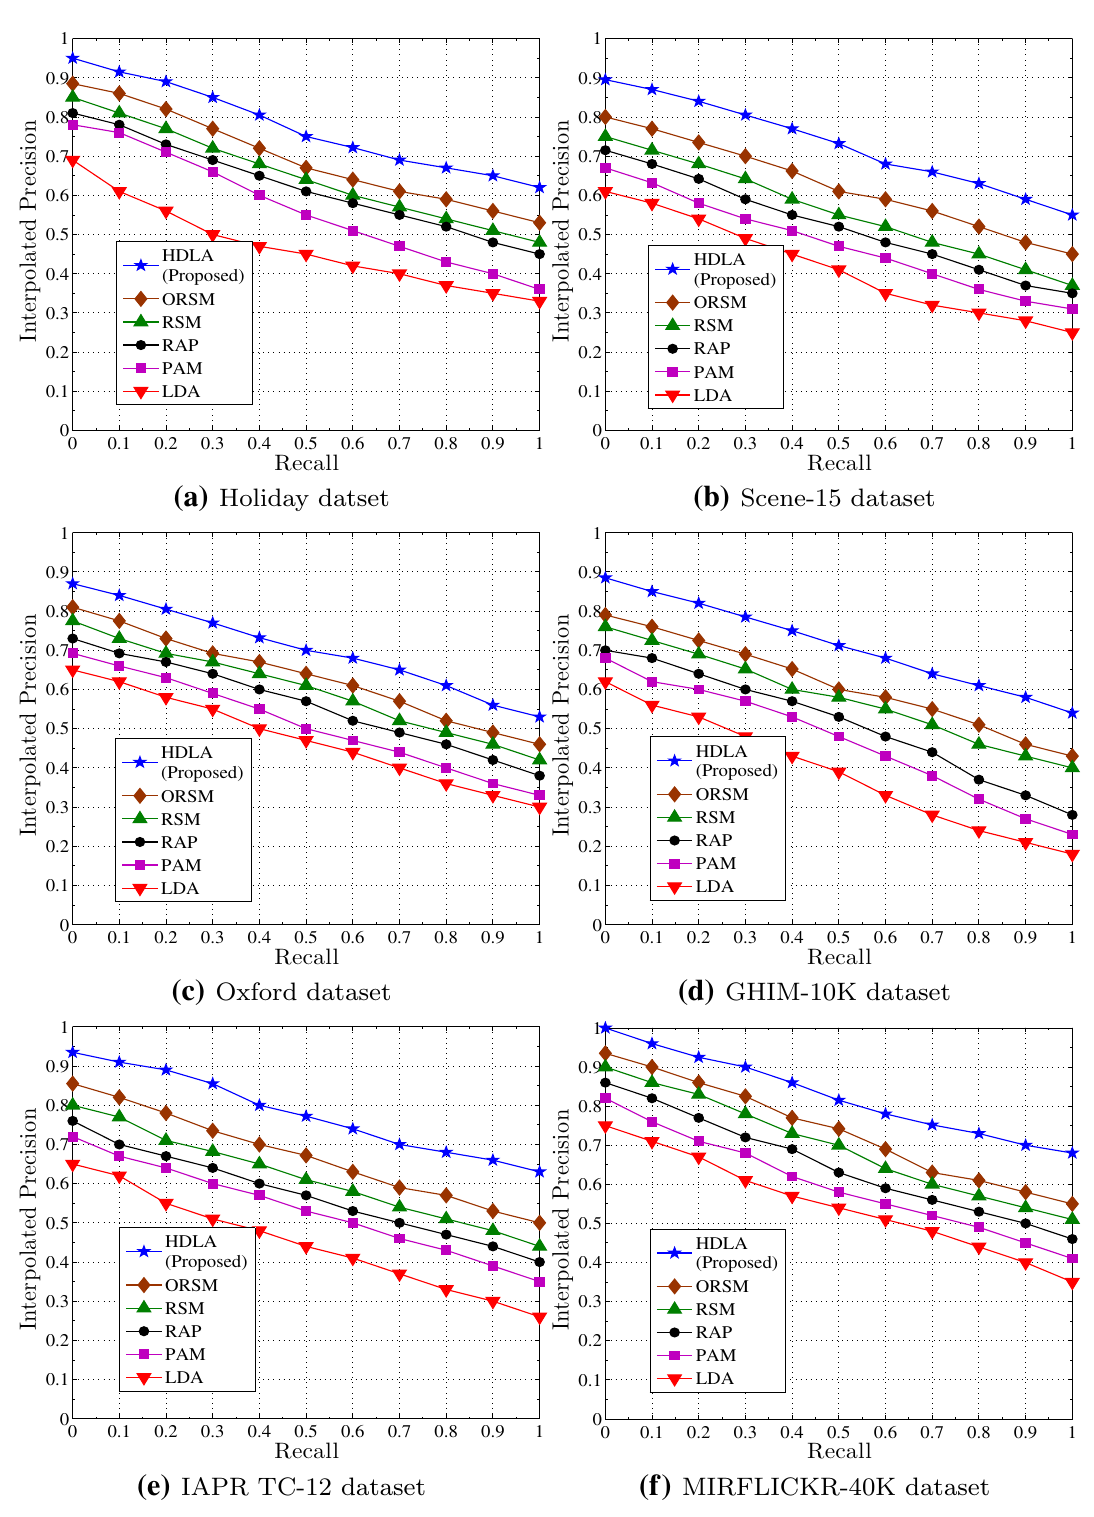
Fig. 10 Evaluation of the proposed HDLA-based image retrieval framework in comparison with state-of-the-art approaches based on 11-point interpolated average precision. a Holiday datset. b Scene-15